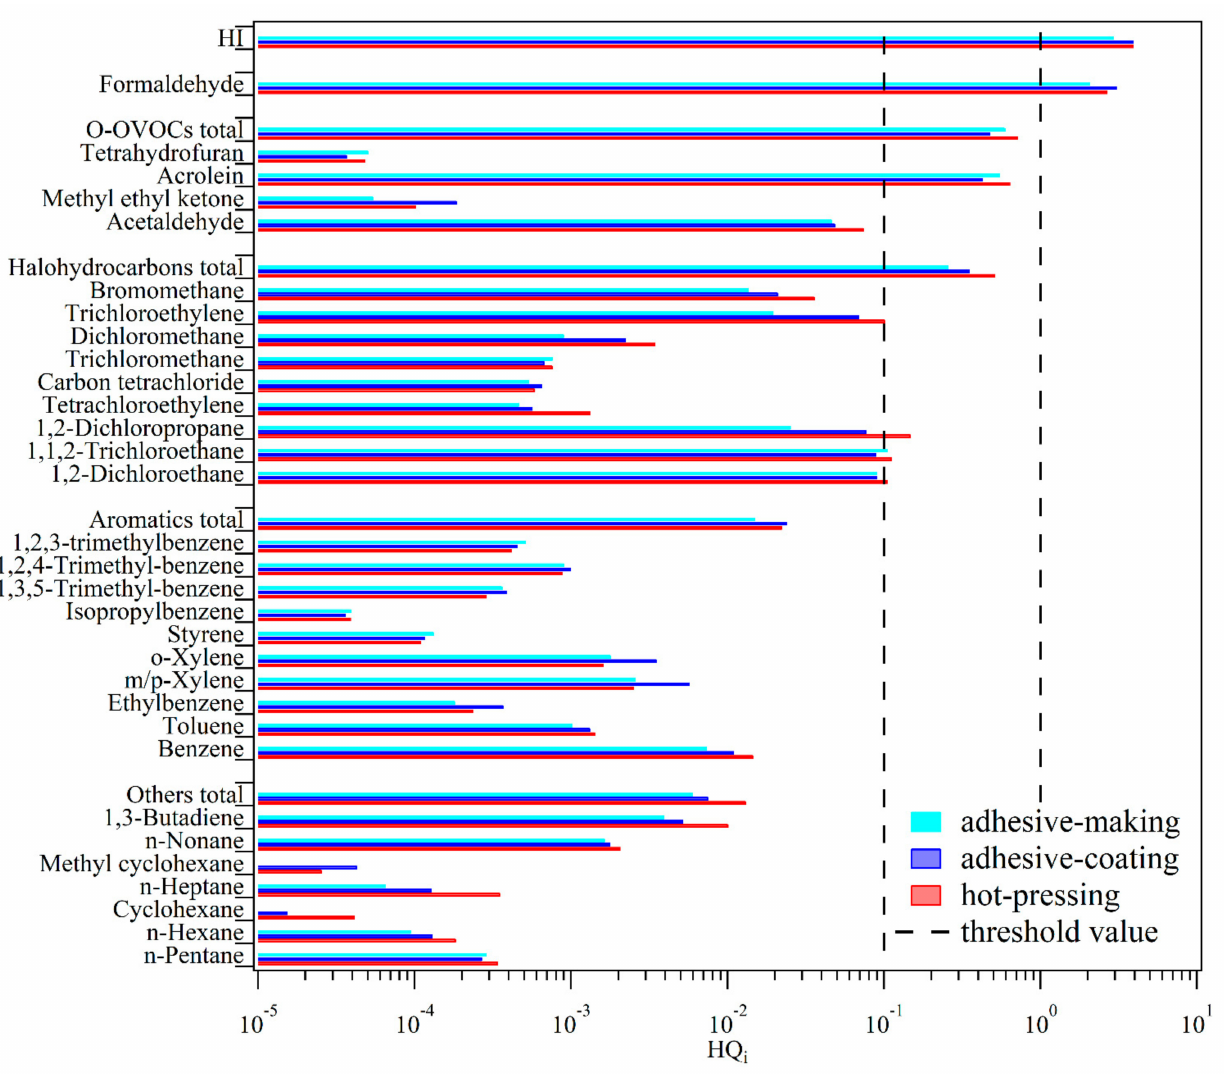
Figure 5. Non-cancer toxic health risks for individual VOC species (HQ) and total VOCs (HI) from three processes of the plywood manufacturing industry. The dotted lines indicate the threshold